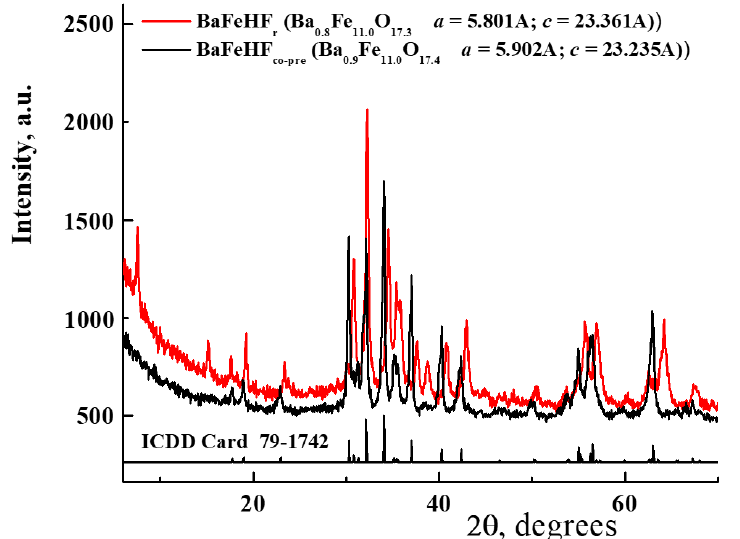
Figure 9. XRD patterns of BaFeHF phases obtained by co-precipitation and K-promotion (black line) and by decomposition of 6%K/BaFeHAl-30 material during reduction at 550 °C (red line). Comparison of XRD patterns of BaFeHF phases obtained by co-precipitation and reduction